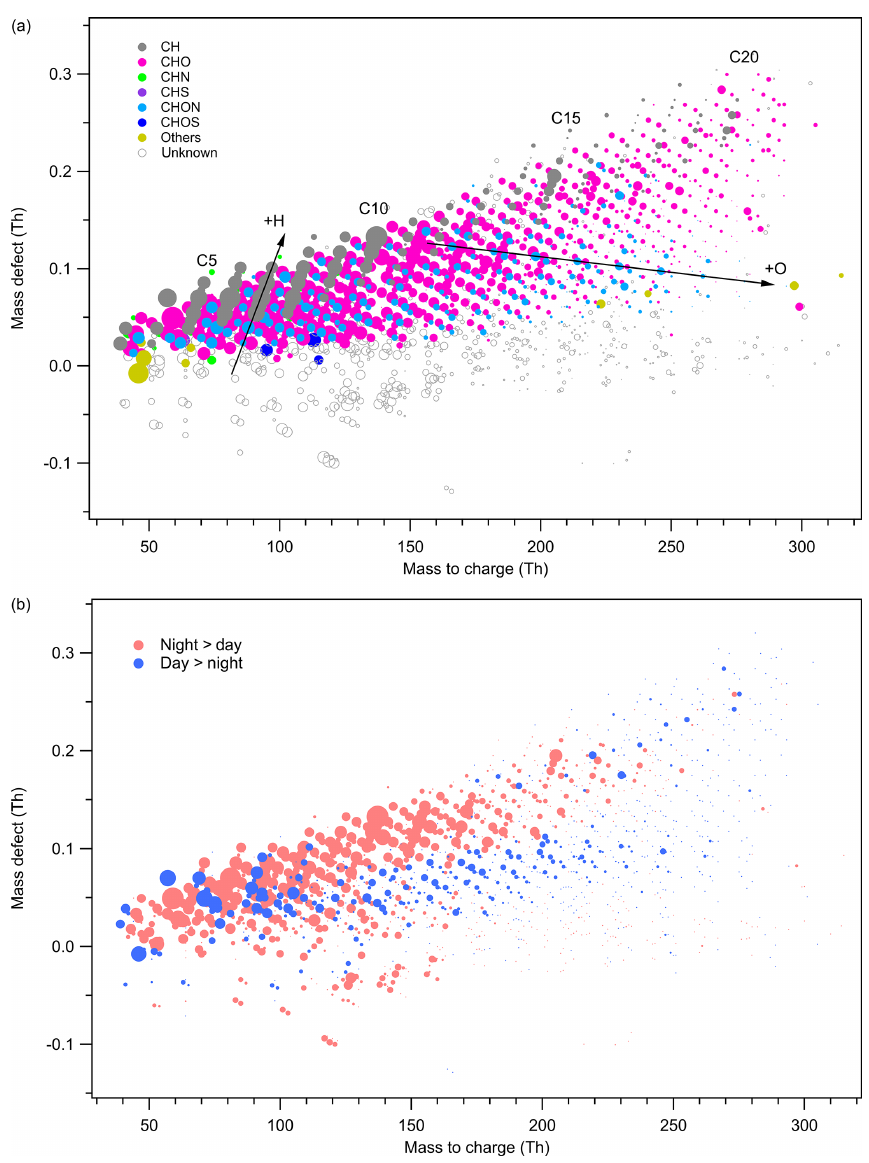
Figure 2. Mass defect plot of the ions identified by high-resolution analysis of the Vocus PTR-TOF data set. The x axis shows the mass-to- charge ratio and the y axis shows the mass defect, which is the deviation of the exact mass from the nominal mass. Data points in (a) are color coded by ion family (CH, CHO, CHN, CHS, CHON, CHOS) and sized by the logarithm of peak area. Data points in (b) are shown in pink when signals are higher during nighttime and in blue when daytime signal is higher. The symbol size corresponds to the difference of daytime and nighttime signal for the molecule. It should be noted that ions < 35Th are detected at a much reduced efficiency due to a high-pass band filter in the